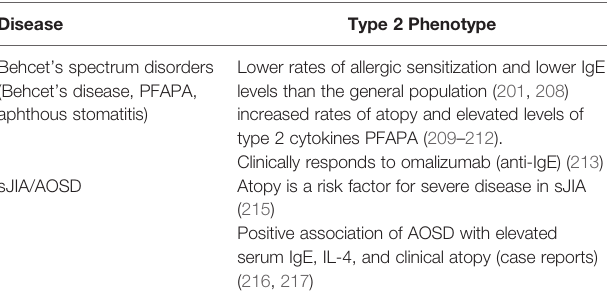
TABLE 2 | Associations of complex autoin fl ammatory diseases with type 2 clinical and immunological phenotypes. Disease Type 2 Phenotype Behcet ’ s spectrum disorders (Behcet ’ s disease, PFAPA, aphthous